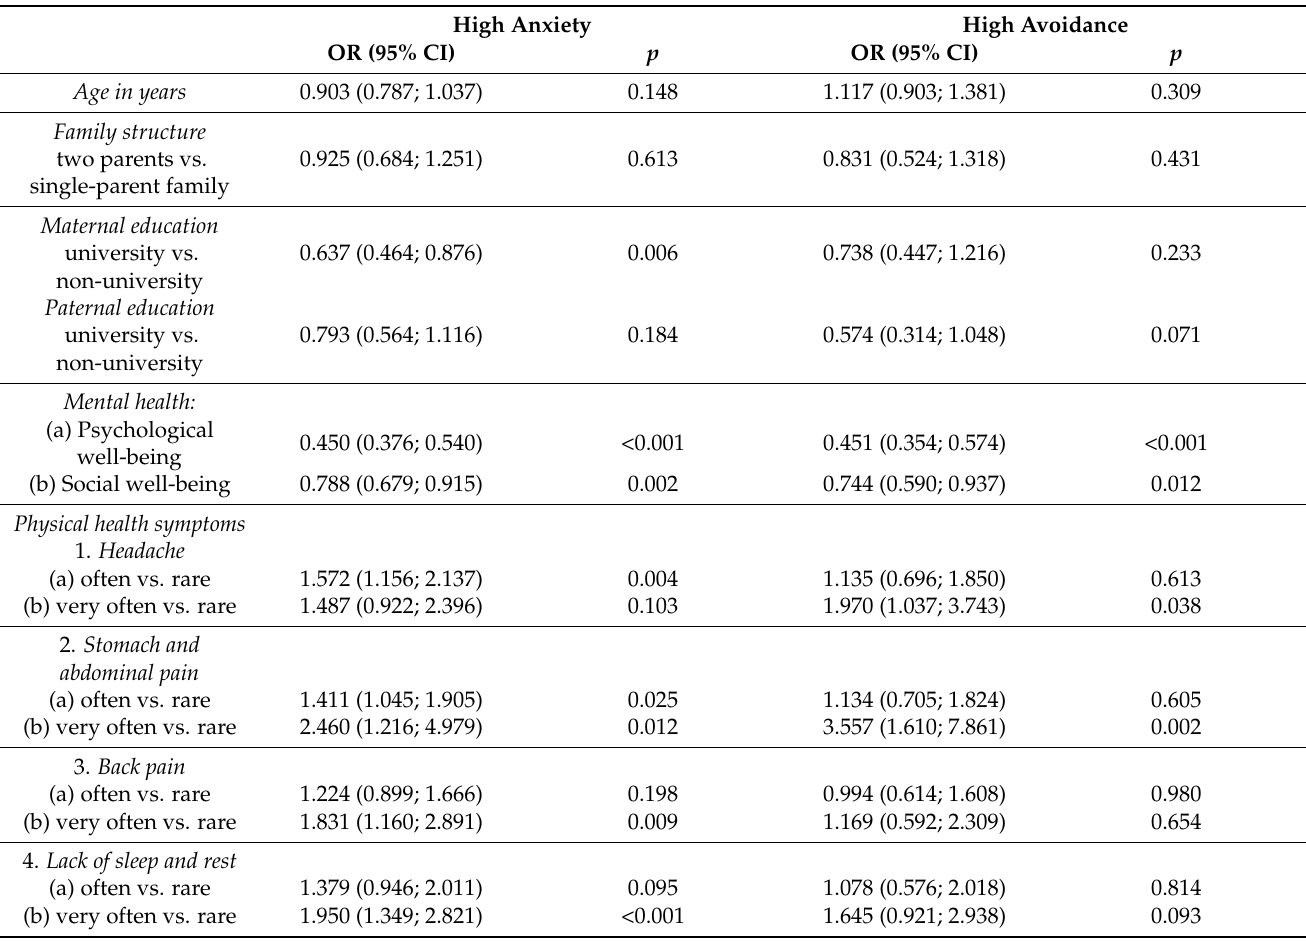
Table 4. Univariate logistic regression: the ratio of males’ odds ratio to be high on SA (anxiety and avoidance groups). High Anxiety High Avoidance OR (95% CI) p OR (95% CI) p 0.903 (0.787;